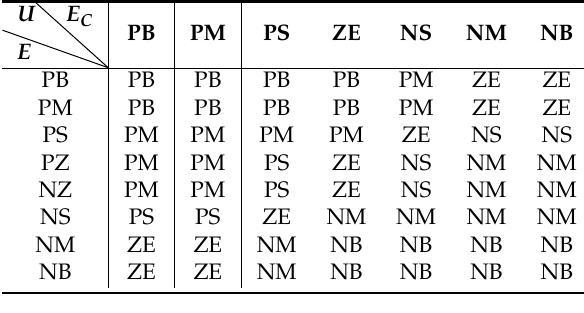
Table 1. Fuzzy control rules. PB: positive big; PM: positive medium; PS: positive small; NE: